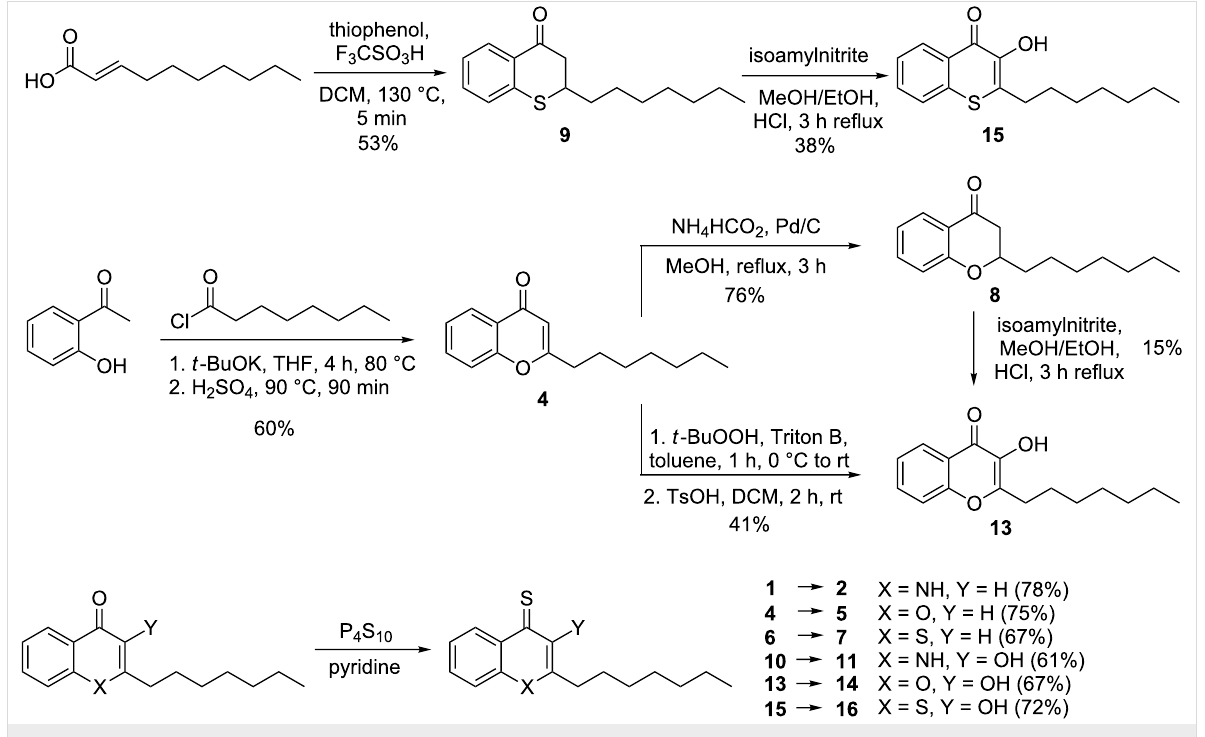
Scheme 1: Synthesis of various HHQ and PQS analogues.